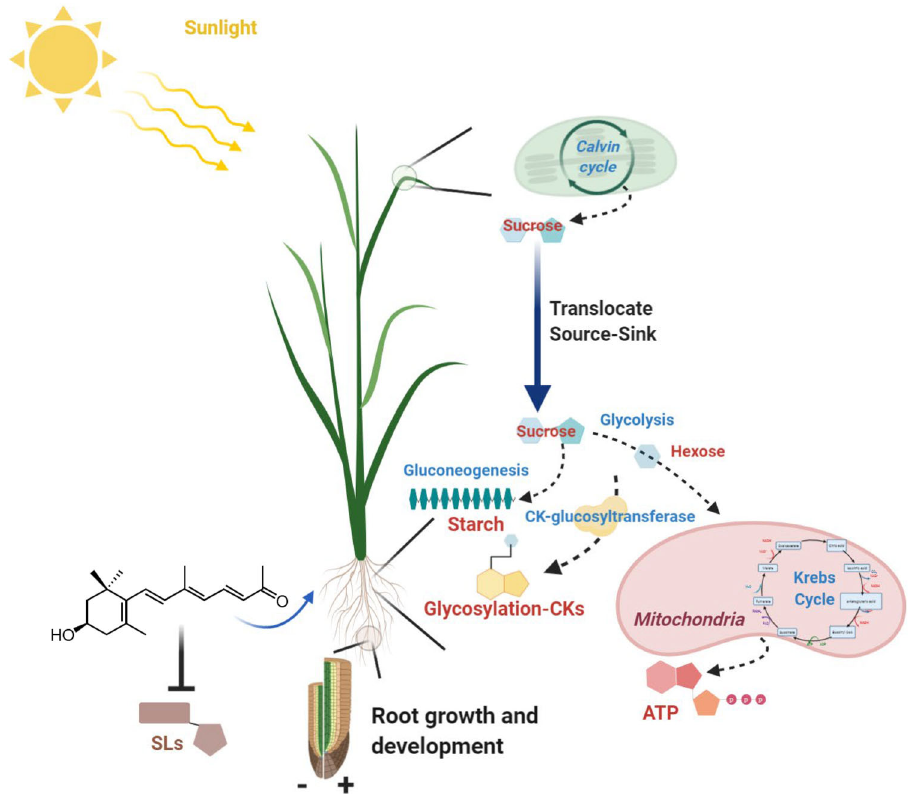
Fig. 5 Model of the mechanisms underlying the growth-promoting effect of zaxinone in rice. Application of zaxinone might enhance photosynthesis activity (Calvin cycle) that produces sucrose that is translocated from the shoot (source) to developing root tissues (sink). Sucrose then can either be hydrolyzed (glycolysis) into hexose that enters glycolysis and citric acid cycle (to produce ATP and C-building blocks), or stores as starch formed by gluconeogenesis. The glucose can also be used for cytokinin glycosylation that regulates the bioactivity of CKs in rice root tissues. A combination of these effects results in root phenotypical changes and cellular events, such as a larger meristem size. In addition, zaxinone suppresses SL biosynthesis and release, while it cannot rescue the SL biosynthesis and perception mutants 22 and does not affect the central metabolism in the SL biosynthetic d17 mutant. Created with “ Biorender ”